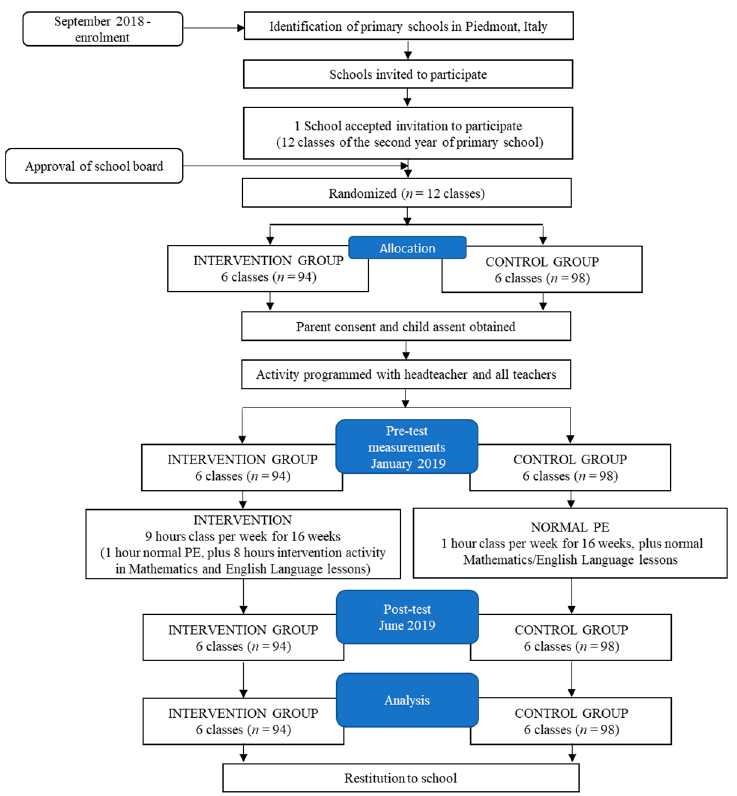
Figure 1. Experimental design and CONSORT flow diagram. (PE: Physical Education).